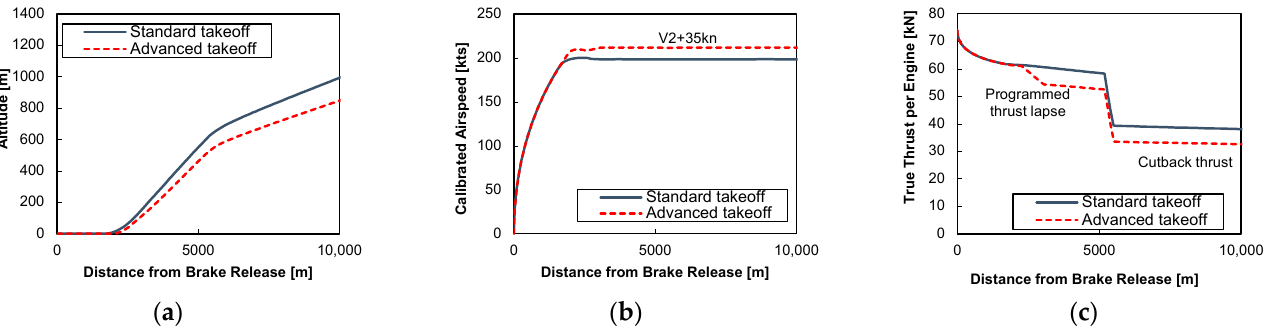
Figure 3. Flight path and thrust setting for the standard and the advanced takeoff procedure: ( a ) trajectory; ( b ) calibrated air speed; ( c ) thrust per engine.